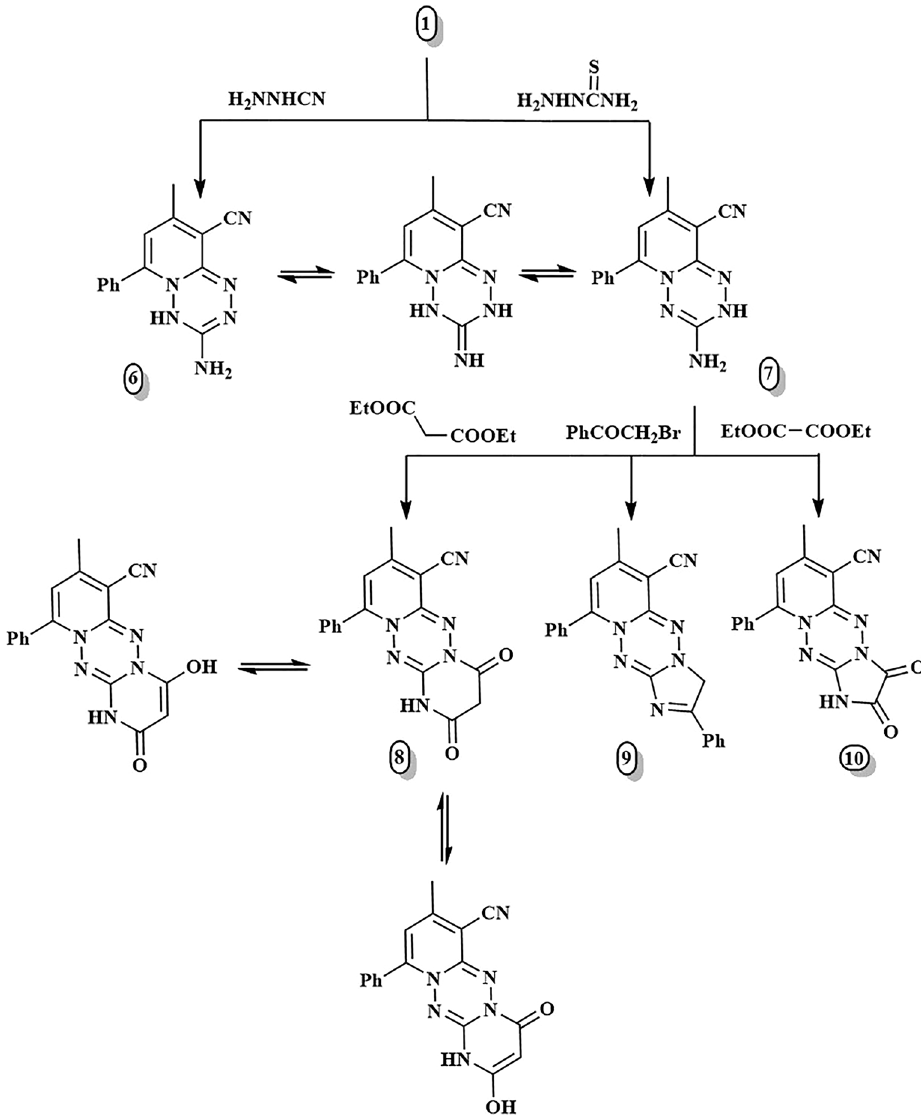
Figure 2. Synthesis of compounds 6 – 10